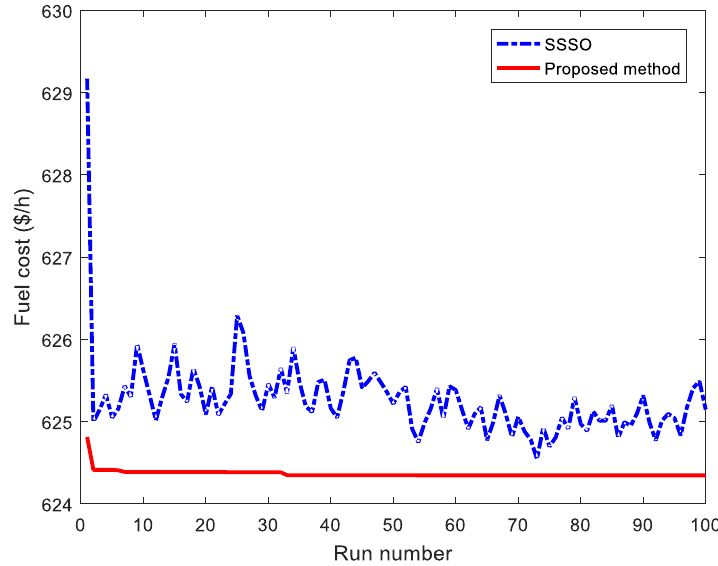
Figure 4. The best fitness functions of 100 runs obtained by SSSO and ISSO for case 1 of system 2.